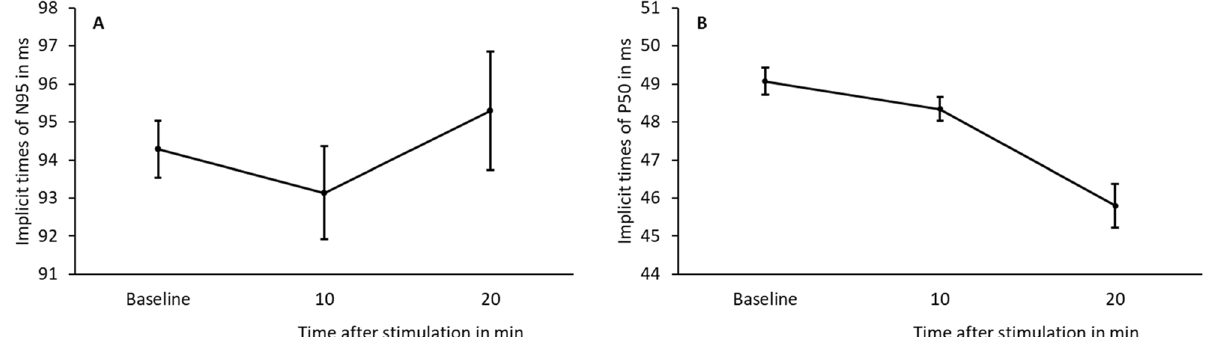
Figure 4. Mean and standard error of the mean (SEM) of implicit time of PERG P50 ( A ) and N95 ( B ) in ms of baseline and 10 and 20 min after blue light stimulation of the blind-spot in 5 myopes.